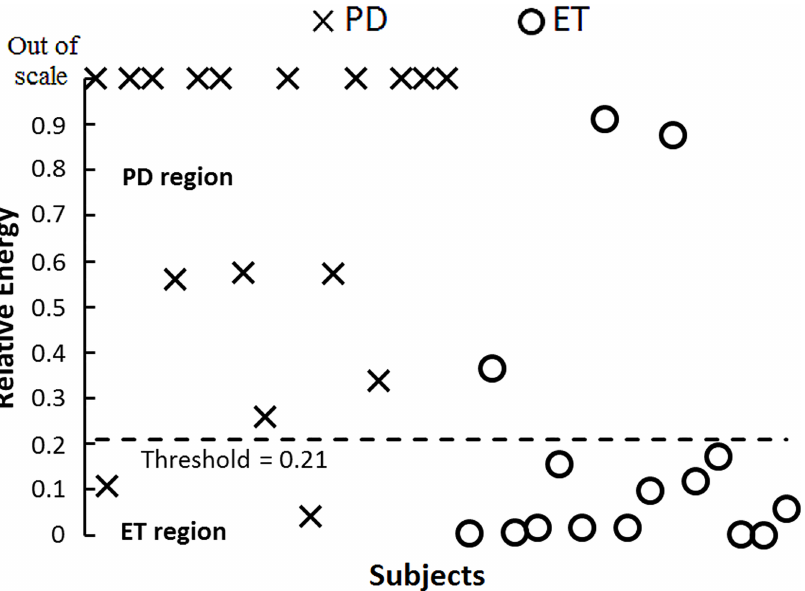
Fig 4. Discrimination of Parkinson’s disease and essential tremor subjects using the threshold obtained from relative energy feature ROC curve. 15 of 17 Parkinson’s and 13 of 15 essentialtremor patients were correctly classified.PD region, values in this regionare classifiedas Parkinson’sdisease.ET region, values in this regionare classifiedas